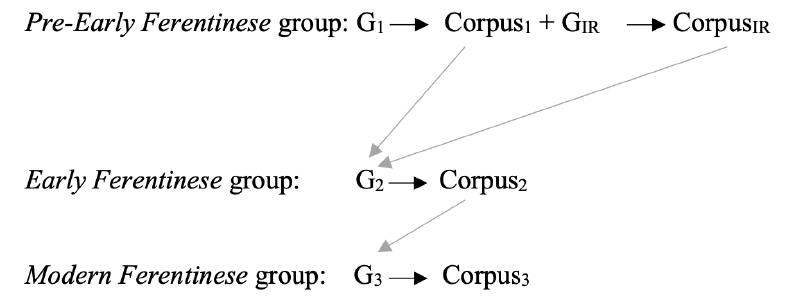
Figure 2. Indirect micro-contact-induced change in